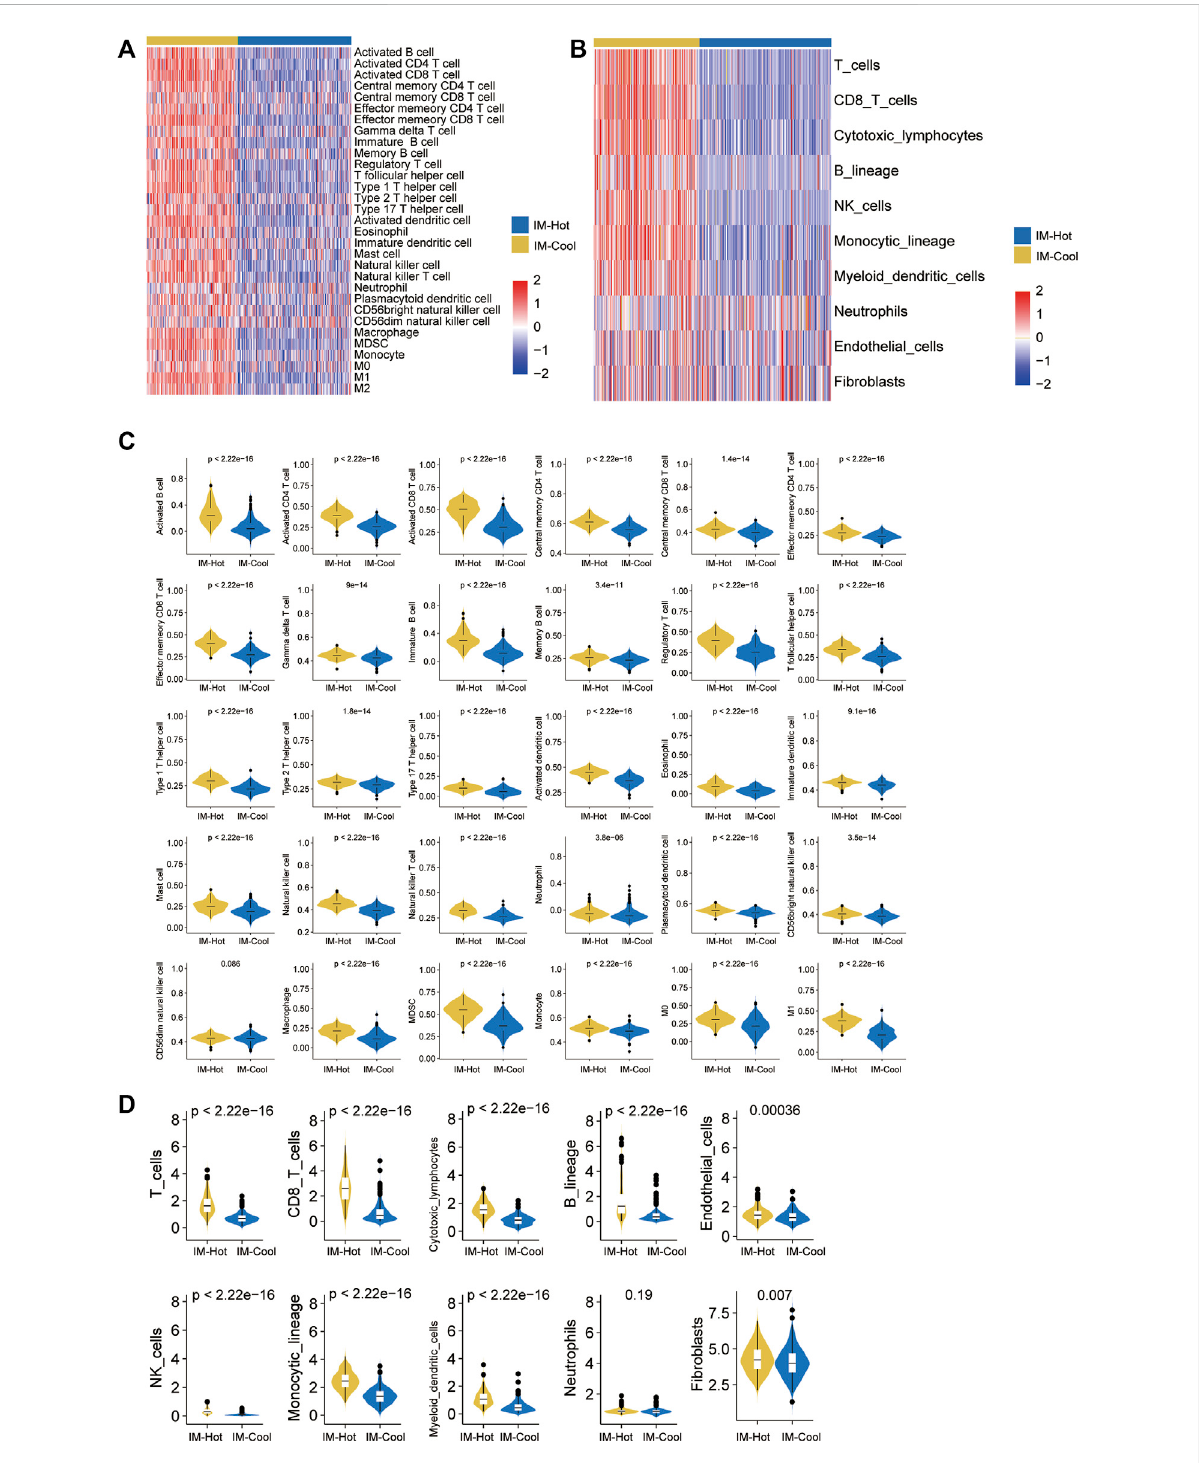
FIGURE 3 Immune characteristics of the two subtypes in TCGA cohort. (A,B) The heatmap showing the abundance of immune-cell populations calculatedbyGSVAandMcpcounterinthetwosubtypes. (C,D) Boxplotsshowtrendsintheabundanceofdifferentimmunecellin fi ltrationsbetween the two subtypes in TCGA